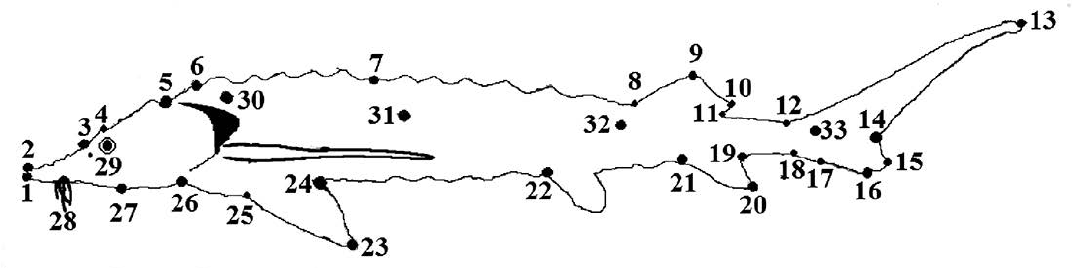
Fig. 2. – Configuration of 33 landmarks for geometric morphometrics of juvenile Persian sturgeon. Landmarks are defined as follows: (1) and (2) snout tip, (3) top of nares, (4) top of eye, (5) dorsal margin of head directly above, (6) position of the first dorsal scut, (7) position of the middle dorsal scut, (8) anterior insertion of the dorsal fin, (9) maximum height of dorsal fin, (10) minimum height of dorsal fin, (11) posterior insertion of the dorsal fin, (12) and (18) end of caudal peduncle, (13) point of the superior caudal fin, (14) point of fork caudal fin, (15) and (16) anterior and posterior of inferior section of caudal fin lobe, (17) point of the middle semilunar inferior caudal fin lobe, (19) and (21) posterior and anterior insertion of the anal fin, (20) point of the superior anal fin, (22) insertion on the profile of the pelvic fin, (23) point of the superior pectoral fin, (24) and (25) posterior and anterior insertion of the pectoral fin, (26) caudoventral point of the suboperculum, (27) point of the mouth, (28) point of the barbel, (29) center of the eye; (30), (31), (32) and (33) were set for fitting the cubic curve to correct for unnatural dorso-ventral bend.